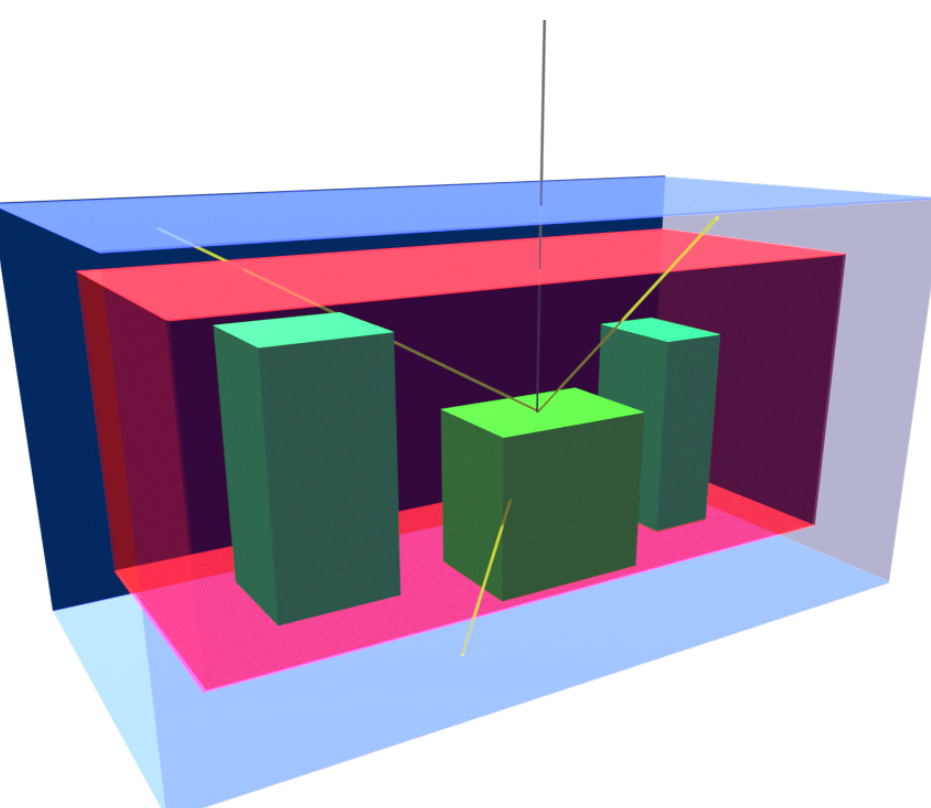
Figure 1. A 3D visualization of the simplified geometry. The detector planes are shown in blue, the container model in red and some generic objects representing the container content in green. In addition, an example of a trajectory of an air shower particle (gray line) with secondary particle production (yellow lines) is